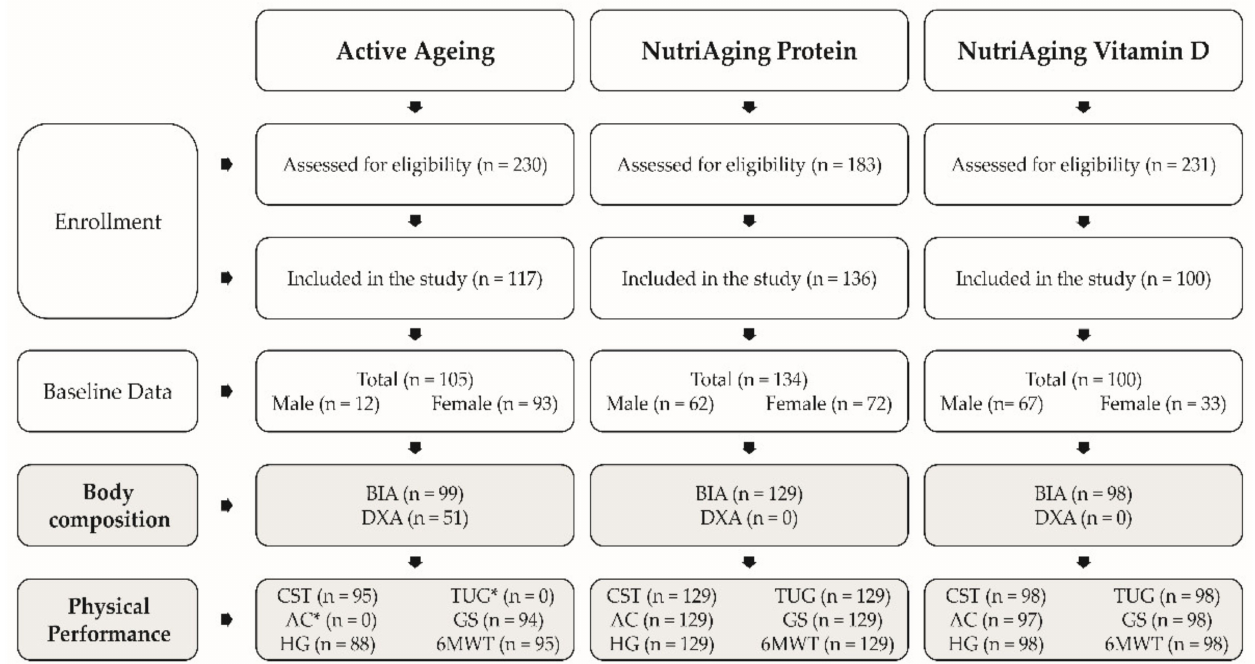
Figure 1. Participants’ flow. RT = resistance training, CST = 30 s chair stand, AC = 30 s arm curl, HG = handgrip strength, TUG = timed up and go test, GS = gait speed, 6MWT = 6 min walk test, * not measured in the Active Ageing